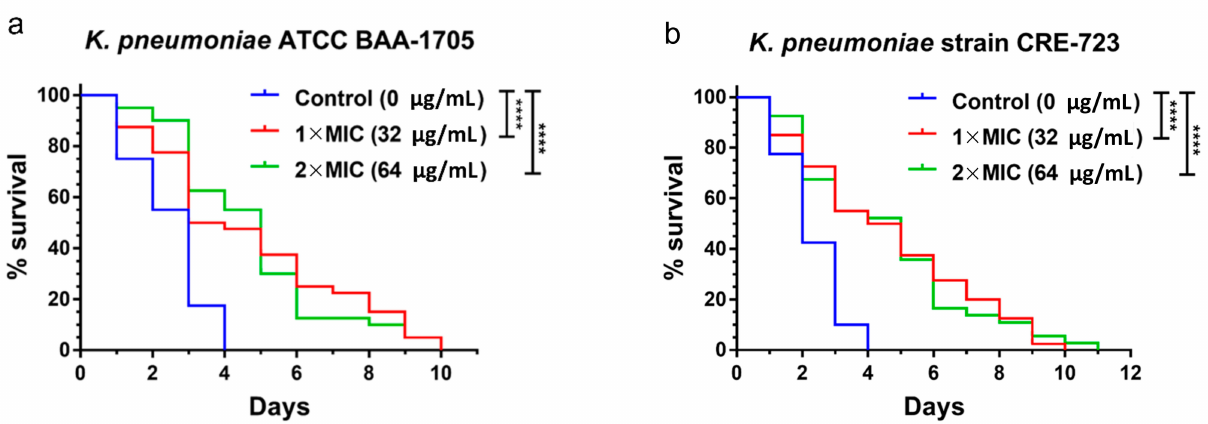
Figure 4. AS101-conferred treatment effects to C. elegans against K. pneumoniae infection. Nematodes (40 per group) were infected with ( a ) carbapenem-resistant K. pneumoniae (CRKP) ATCC BAA-1705, or ( b ) colistin-resistant CRKP isolate CRE-723, and treated with AS101 at various concentrations. Nematode survival was recorded daily. **** p <